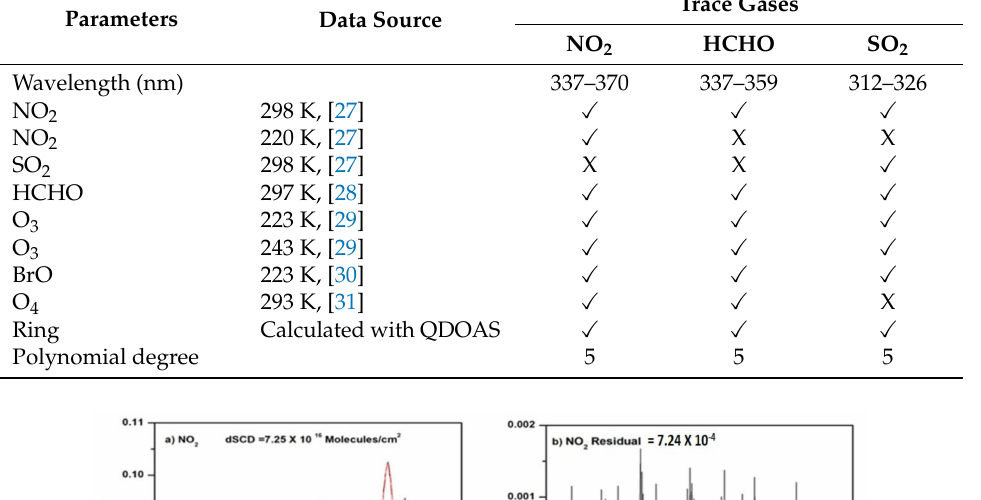
Table 1. Detailed Settings for the spectral analysis of NO 2 , HCHO, and SO 2 using DOAS.